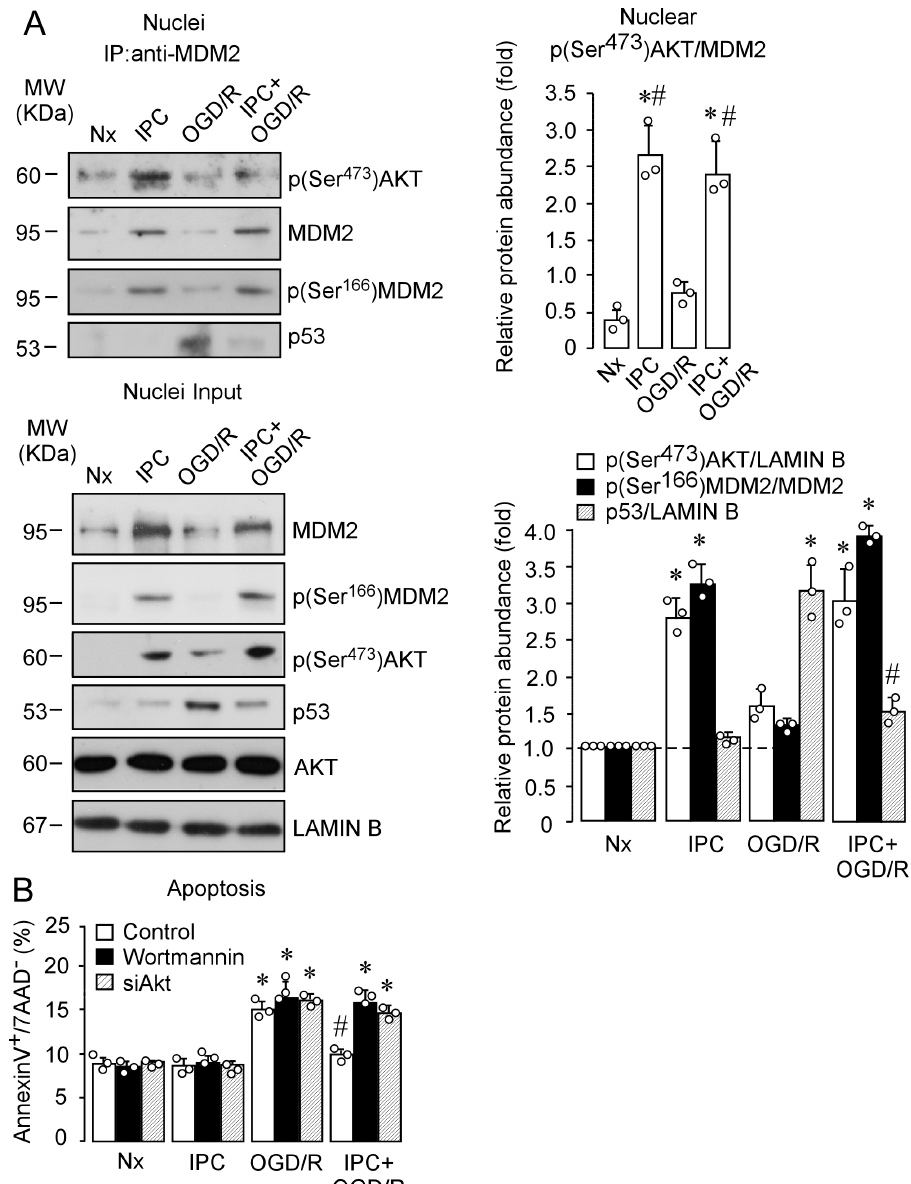
Figure 6. Nuclear p(Ser 4730 )AKT–MDM2 interaction may be essential to ensure IPC-promoted neuronal tolerance against ischemia. Neurons were exposed to Nx, IPC, OGD/R, and IPC + OGD/R, and the subcellular location of MDM2 and p(Ser 473 )AKT, as well as the possible protein interaction, was analyzed by nucleus–cytosol fractionation followed by coimmunoprecipitation assay. ( A ) Nuclear neuronal extracts were obtained and immunoprecipitated with anti-MDM2. Expression of MDM2 and p(Ser 473 )AKT proteins was analyzed by Western blot from neuronal immunoprecipitated (IP) samples, while 10% were loaded on SDS-PAGE as a nucleus input control. AKT and LAMIN B were used as loading control. Relative nuclear protein abundance quantification from three different neuronal cultures is presented. M W , molecular weight. ( B ) Neuronal apoptosis was analyzed by flow cytometry. Annexin V/APC-stained neurons that were 7AAD-negative were considered to be apoptotic (represented by the percentage of AnnexinV + /7AAD − neurons). Data are means ± SEM from three different cultures of cortical neurons. In all cases, p < 0.05 was considered significant. Statistical analysis of the results was evaluated in Figure 6A by Student’s t -test. * p < 0.05 versus Nx; # p < 0.05 versus OGD/R. Statistical analysis of the results was evaluated in Figure 6B by one-way ANOVA followed by Bonferroni post hoc. * p < 0.05 versus control Nx; # p < 0.05 versus control